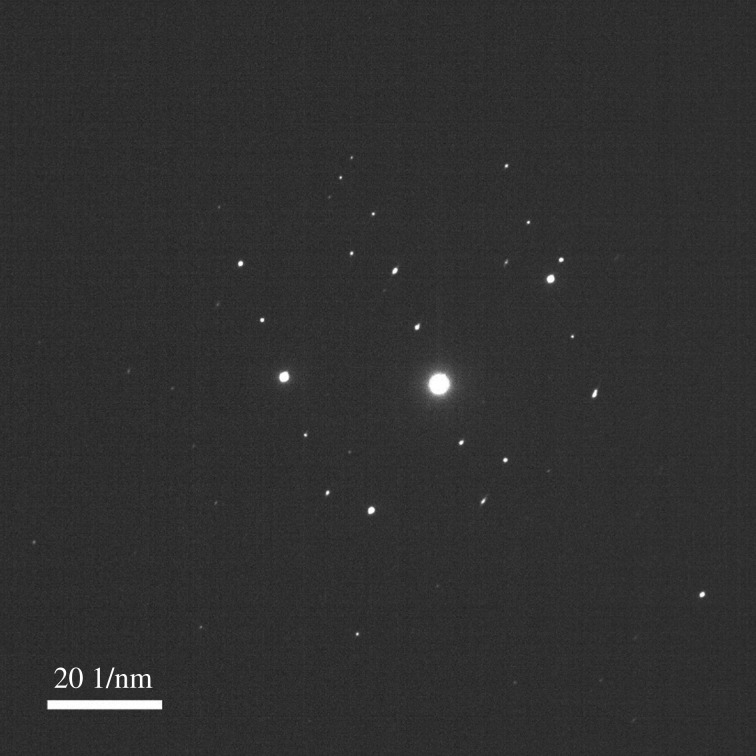
TEM diffraction pattern of the Fe2O3 nanowire arrays heated at 600°C for 90 min from the polished sample.